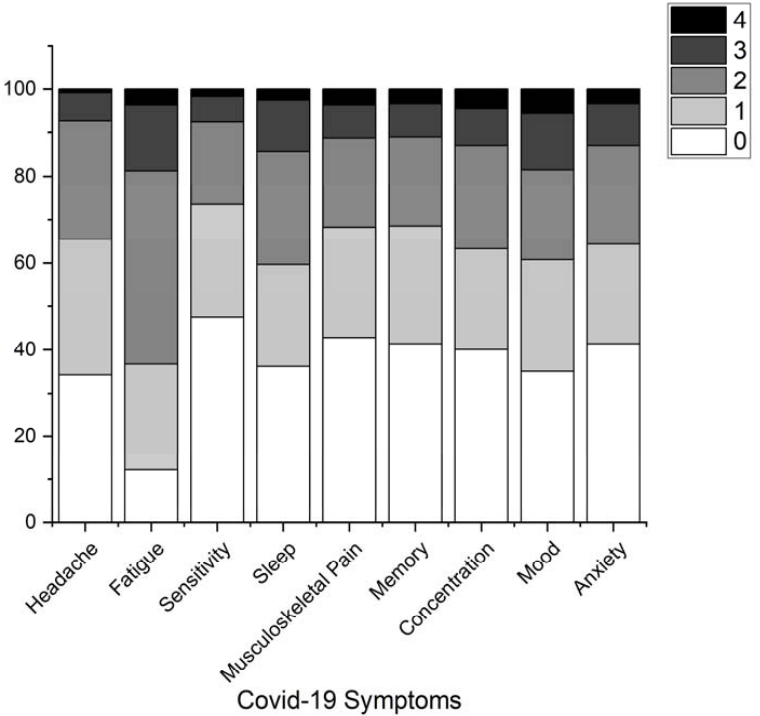
Figure 1. Stitch bar graph representing symptoms experienced by at least 45% of the sample. Symptom severity grouped as in the questionnaire responses: 0 = none; 1 = slight; 2 = mild; 3 = moderate; 4 = severe.